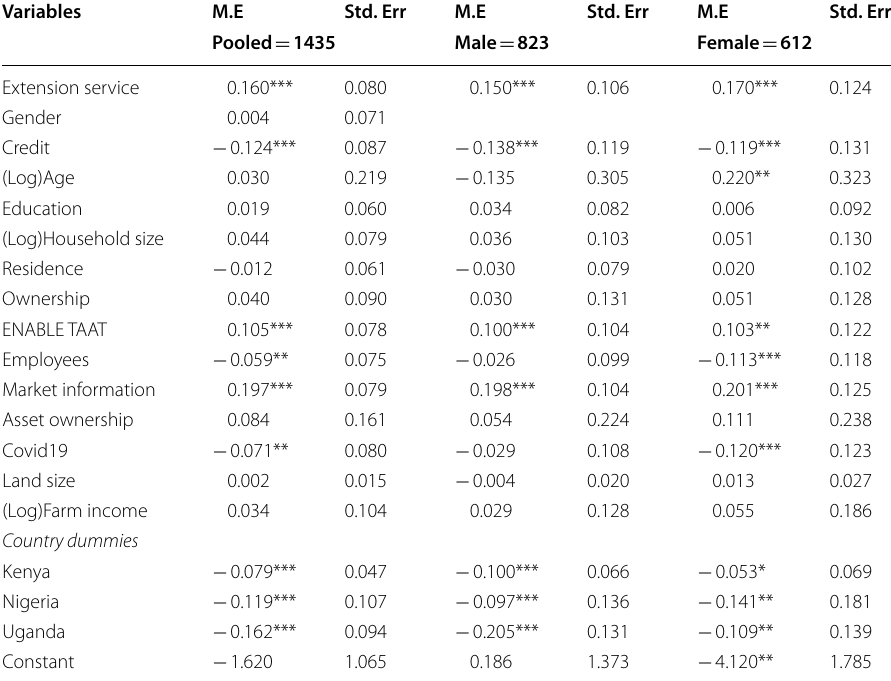
Source Survey data